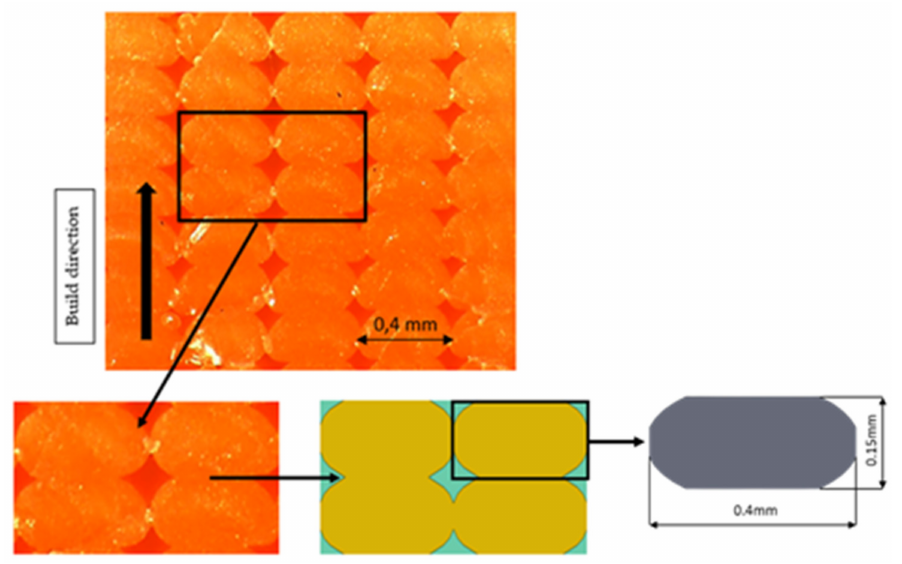
Figure 3. Workflow of geometry selection.